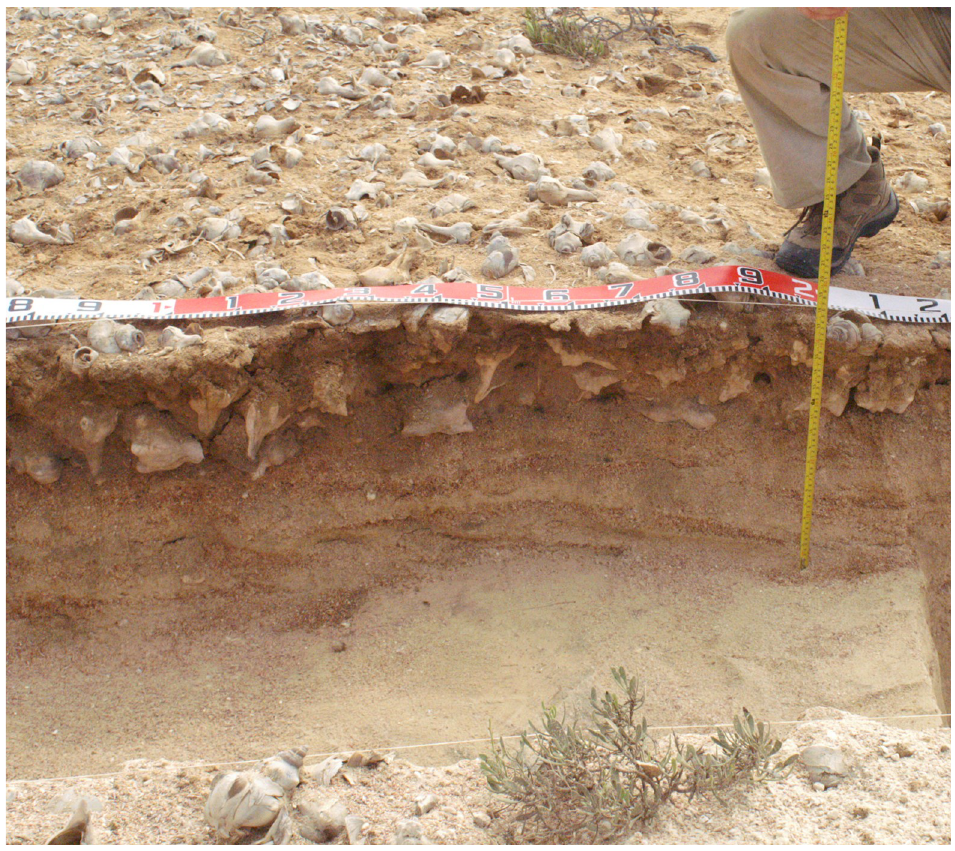
Fig 9. Site JW5697, one of the low-shore middens in the Janaba West-Central cluster on transect 2. The shell matrix is dominated by shells of Chicoreus ramosus and sits directly on a thick beach deposit. Photo by Niklas Hausmann, February